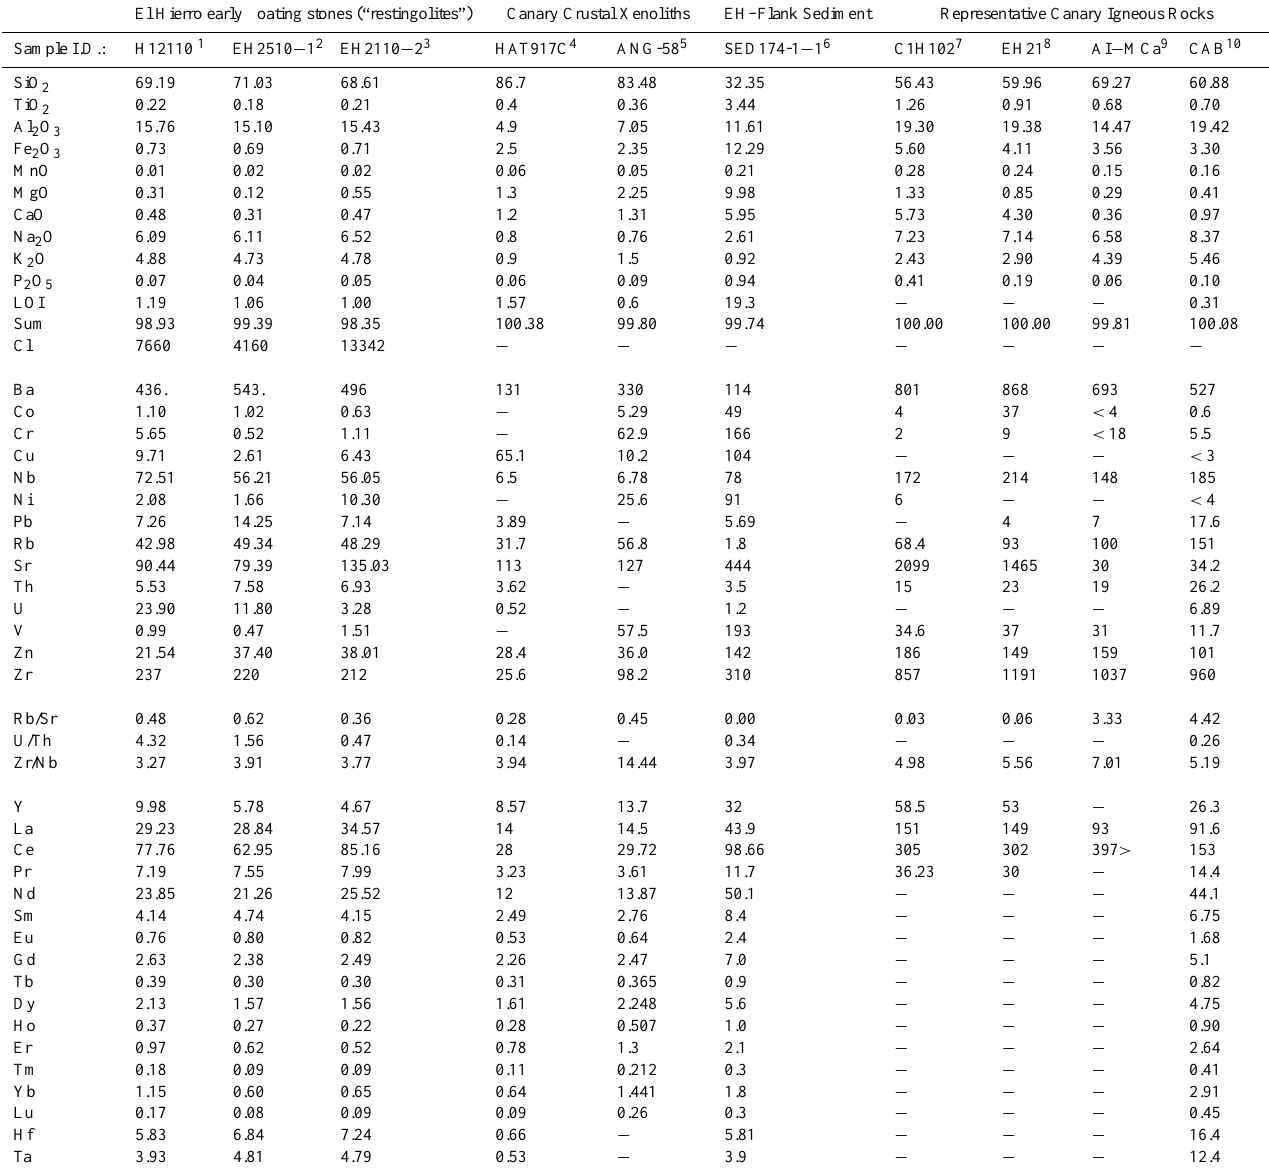
Table 3. Whole-rock major and trace element composition of El Hierro “restingolites” and Gran Canaria and Lanzarote crustal xenoliths, El Hierro flank sediment, and representative Canary Island magmatic rocks for comparison.